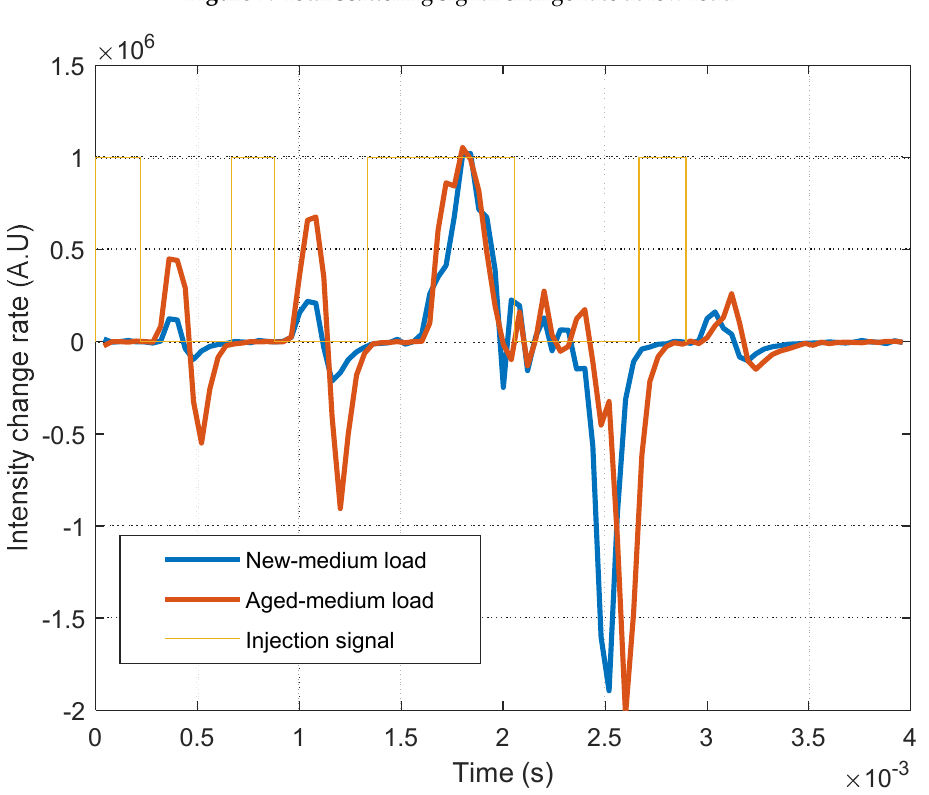
Figure 8. Total scattering signal change rate at medium load.